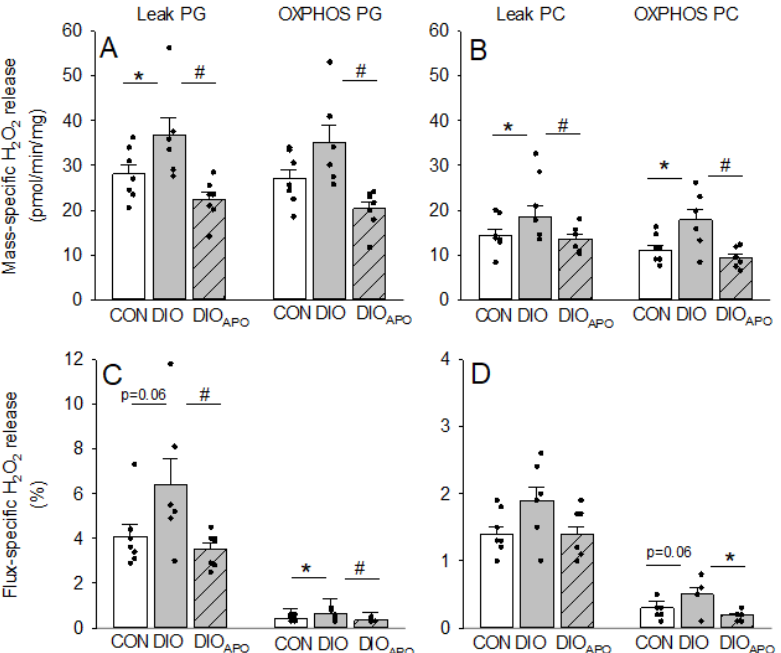
Figure 7. Mass-specific and flux-specific H 2 O 2 - release from isolated cardiac mitochondria using either pyruvate and glutamate (PG, panel A and C ) or palmityol-carnitine as substrates (PC, panel B and D ) as substrates. Mitochondria were obtained from lean controls (CON) and untreated and apocynin-treated obese C57BL / 6J mice (DIO and DIO APO ) fed a western diet for 28 weeks. Single values and means ± SEM, * p < 0.05 CON versus DIO, # p < 0.05 DIO vs. DIO APO .